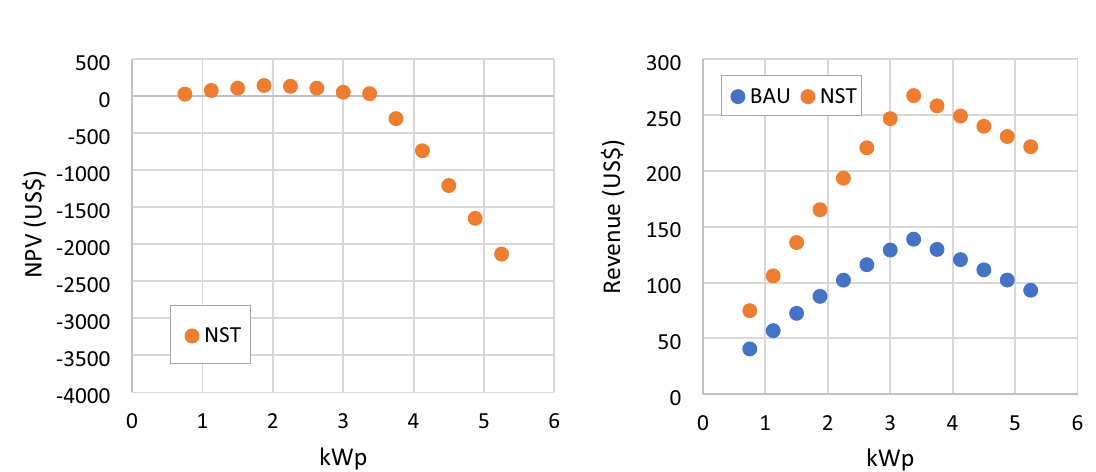
Figure 13. NPV and annual revenue of RSPP with different number of PV modules in BAU and NMS scenario.